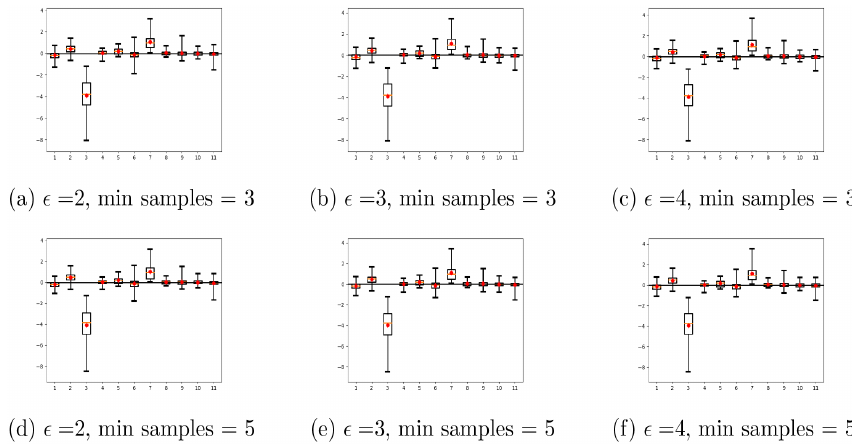
Figure 3. Estimated regression coefficients (i.e., the sensitivity of the model parameters) with median precipitation of the clusters as the response, after clustering with DBSCAN with various parameter values. The red symbols are 95% simultaneous